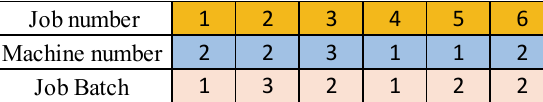
Fig. 3 Random numbers are converted to integer